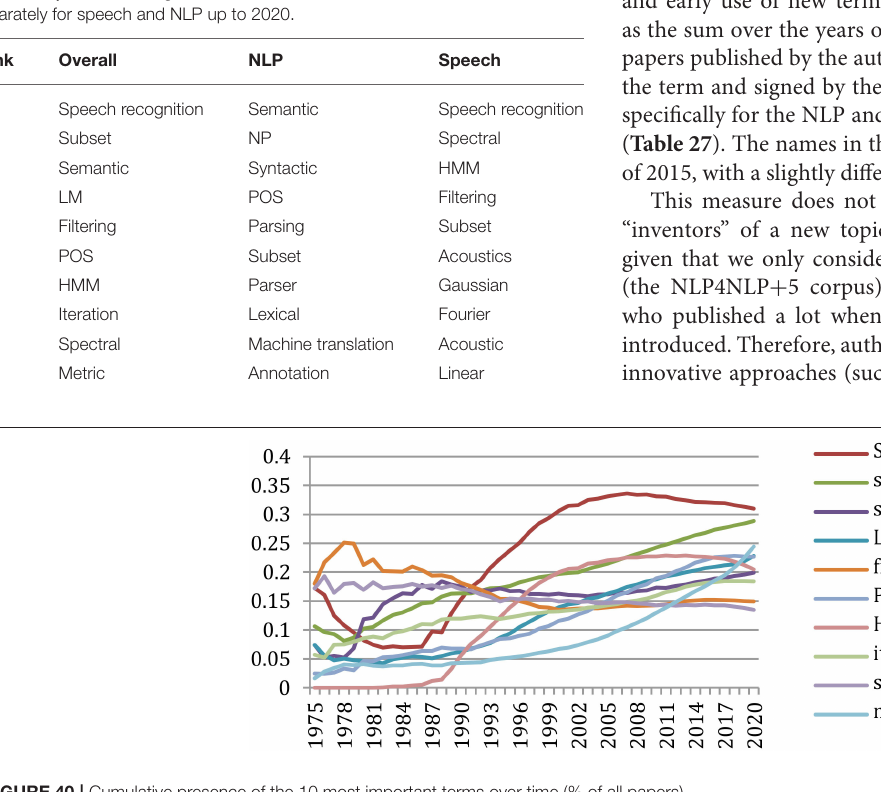
FIGURE 40 | Cumulative presence of the 10 most important terms over time (% of all